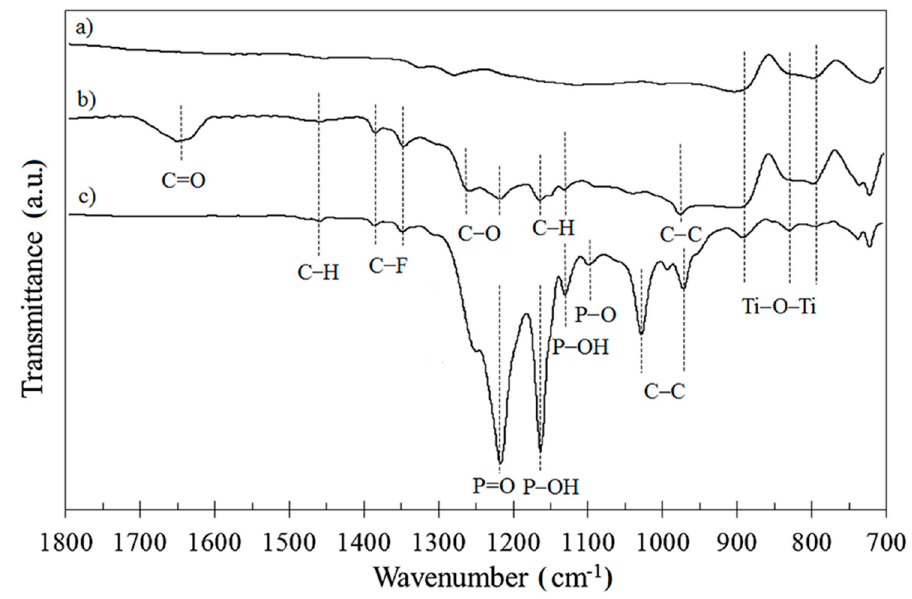
Figure 4. FTIR measurement for ( a ) Ti-6Al-4V, ( b ) Ti-6Al-4V / PFDA, and ( c ) Ti-6Al-4V / Figure 4 . FTIR measurement for ( a ) Ti-6Al-4V, ( b ) Ti-6Al-4V/PFDA, and ( c ) Ti-6Al-4V/PFDPA.